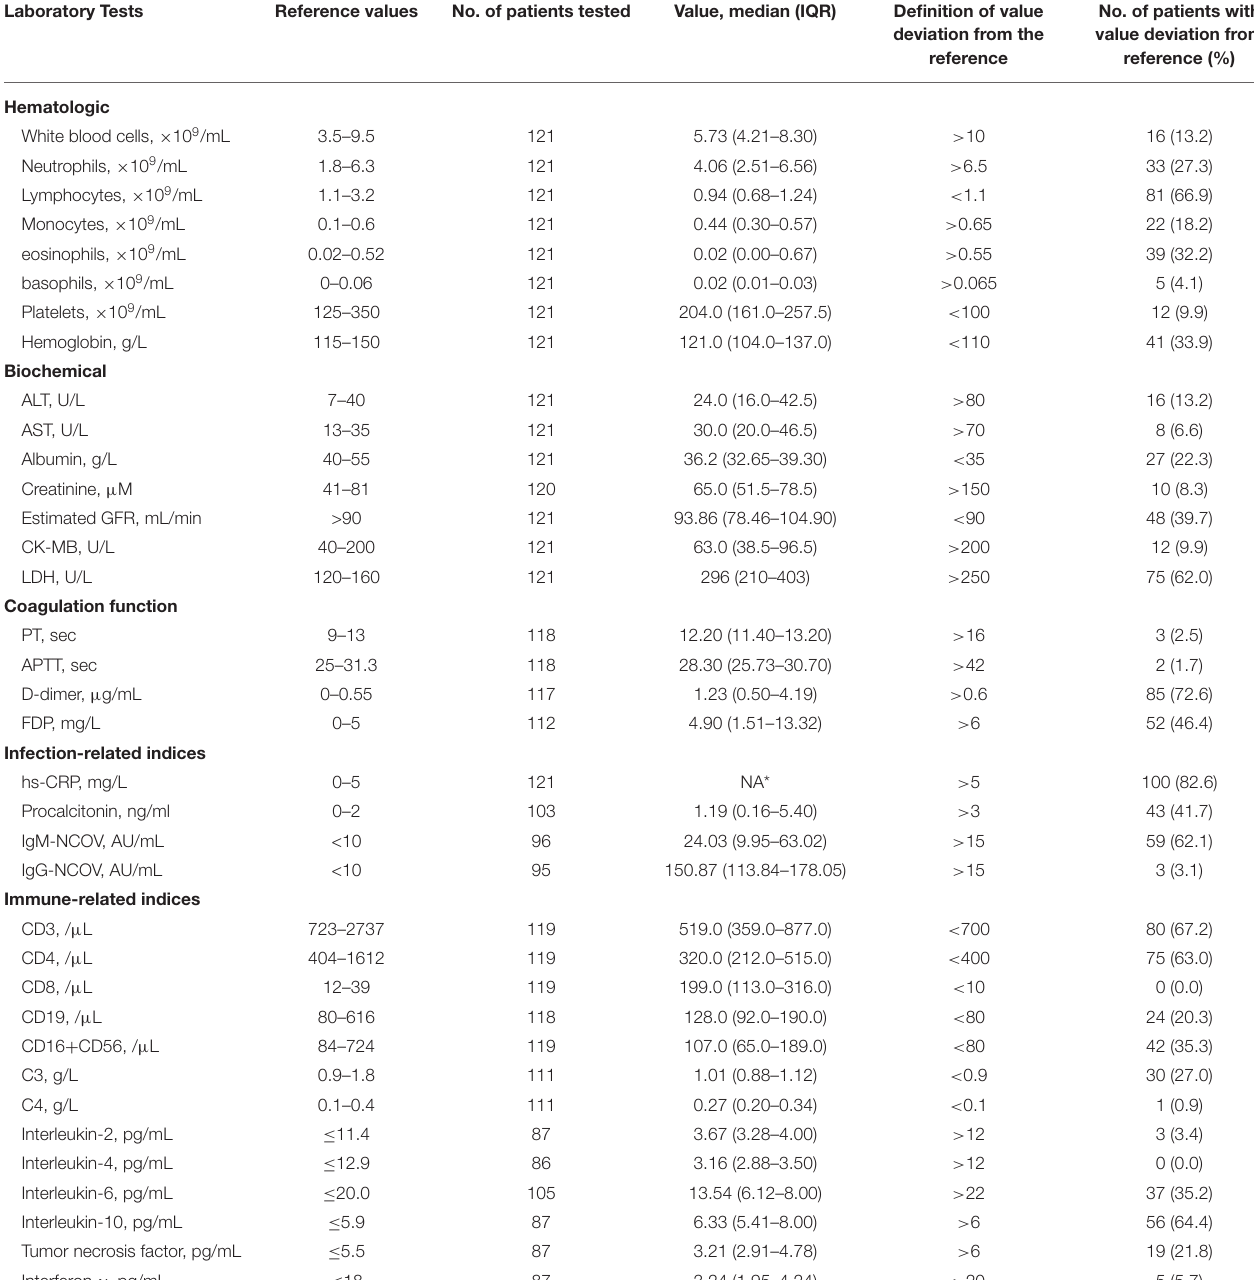
TABLE 2 | Laboratory Indicators of Patients with COVID-19 in